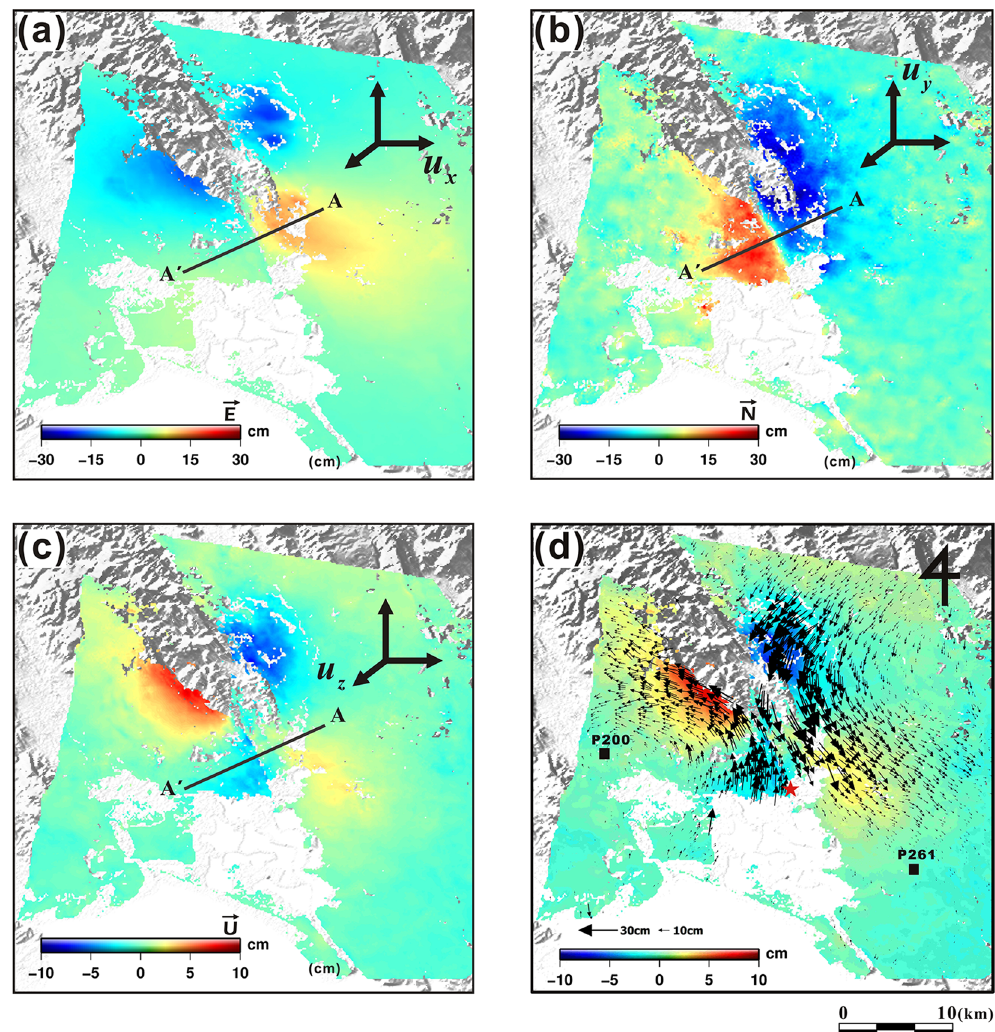
Figure 4. 3D surface displacement maps derived by combining multiple InSAR and MAI displacements measured from CSK and S1A data: ( a ) east, ( b ) north, and ( c ) up components of displacement. ( d ) 3D displacement vector field with arrows showing horizontal movement and colours showing vertical movement from the earthquake. Black small squares and red star represent the locations of GPS stations and the epicentre, respectively. Profile A-A’ is shown in more detail in Fig. 5. The maps were generated by using the GMT software 5.3.2 version